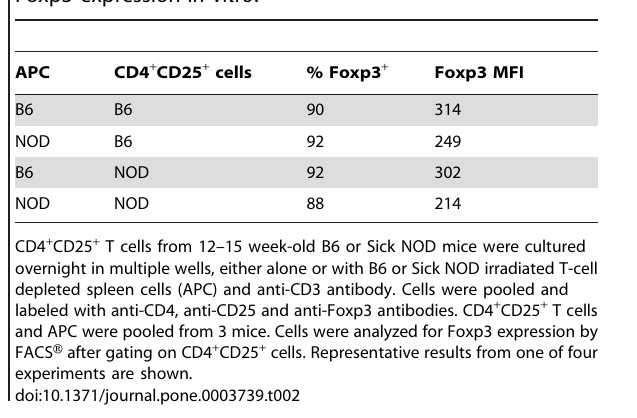
Table 2. APC from NOD mice are less efficient at maintaining Foxp3 expression in vitro .